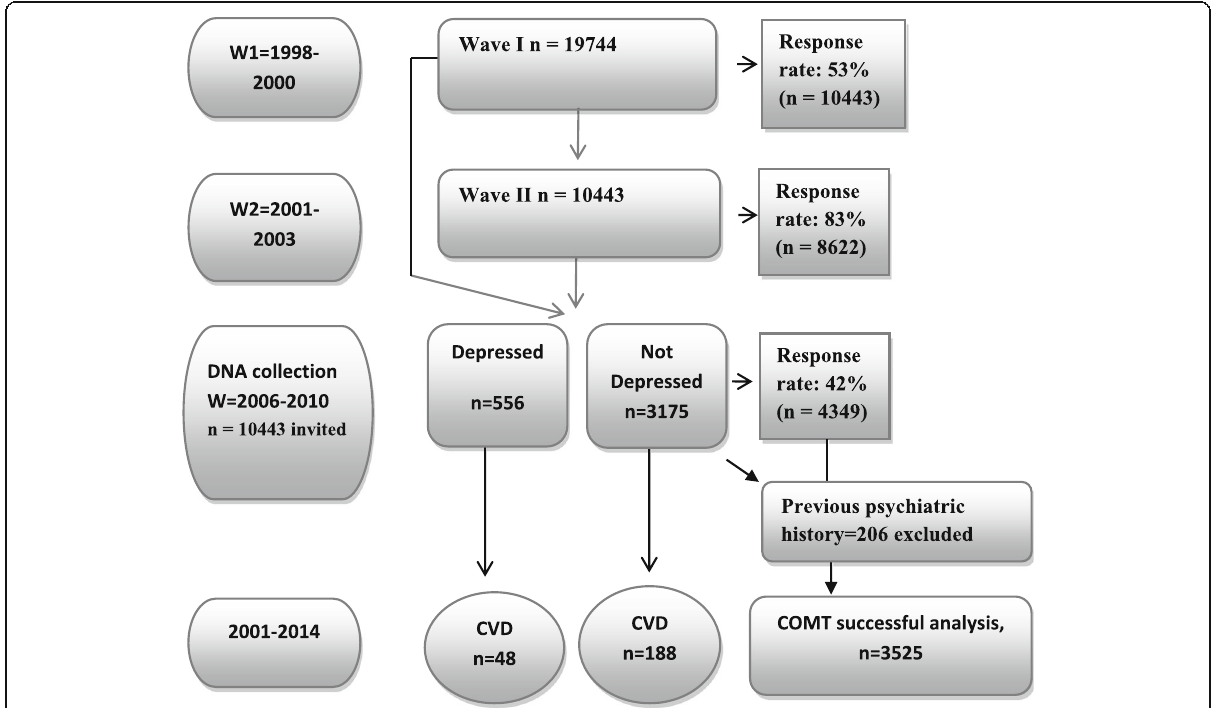
Fig. 1 Patient Recruitment for DNA collection from the PART